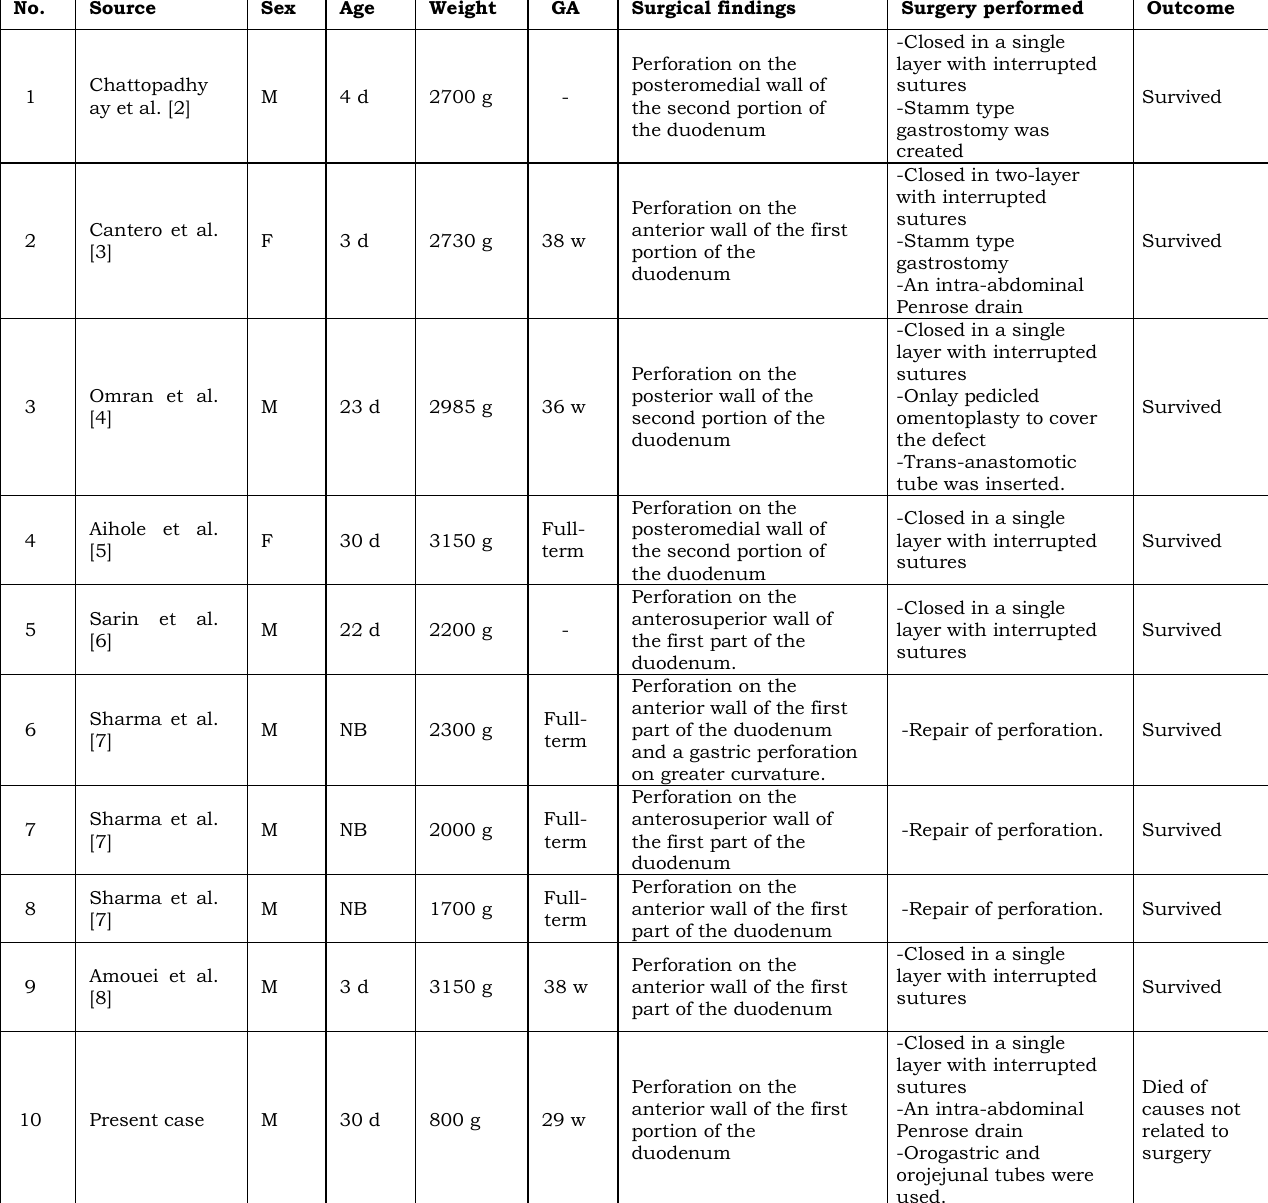
Table 1. Characteristics of duodenal perforation cases in neonates as reported in the